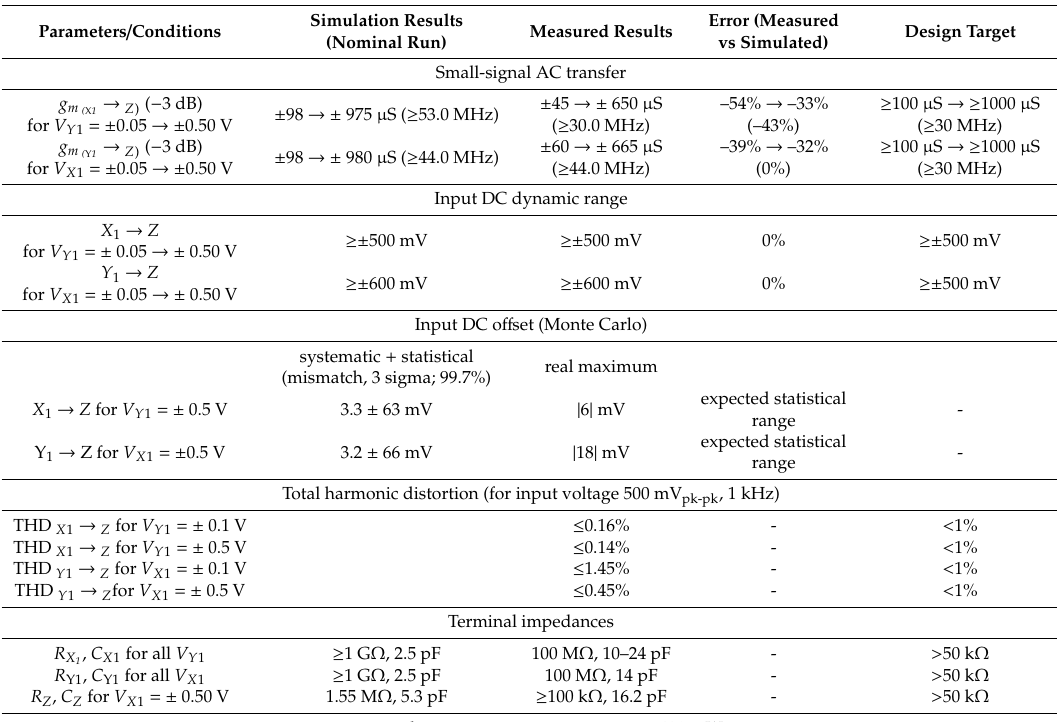
Table A2. Summary of simulated and measured performance of the CMOS MTL cell.